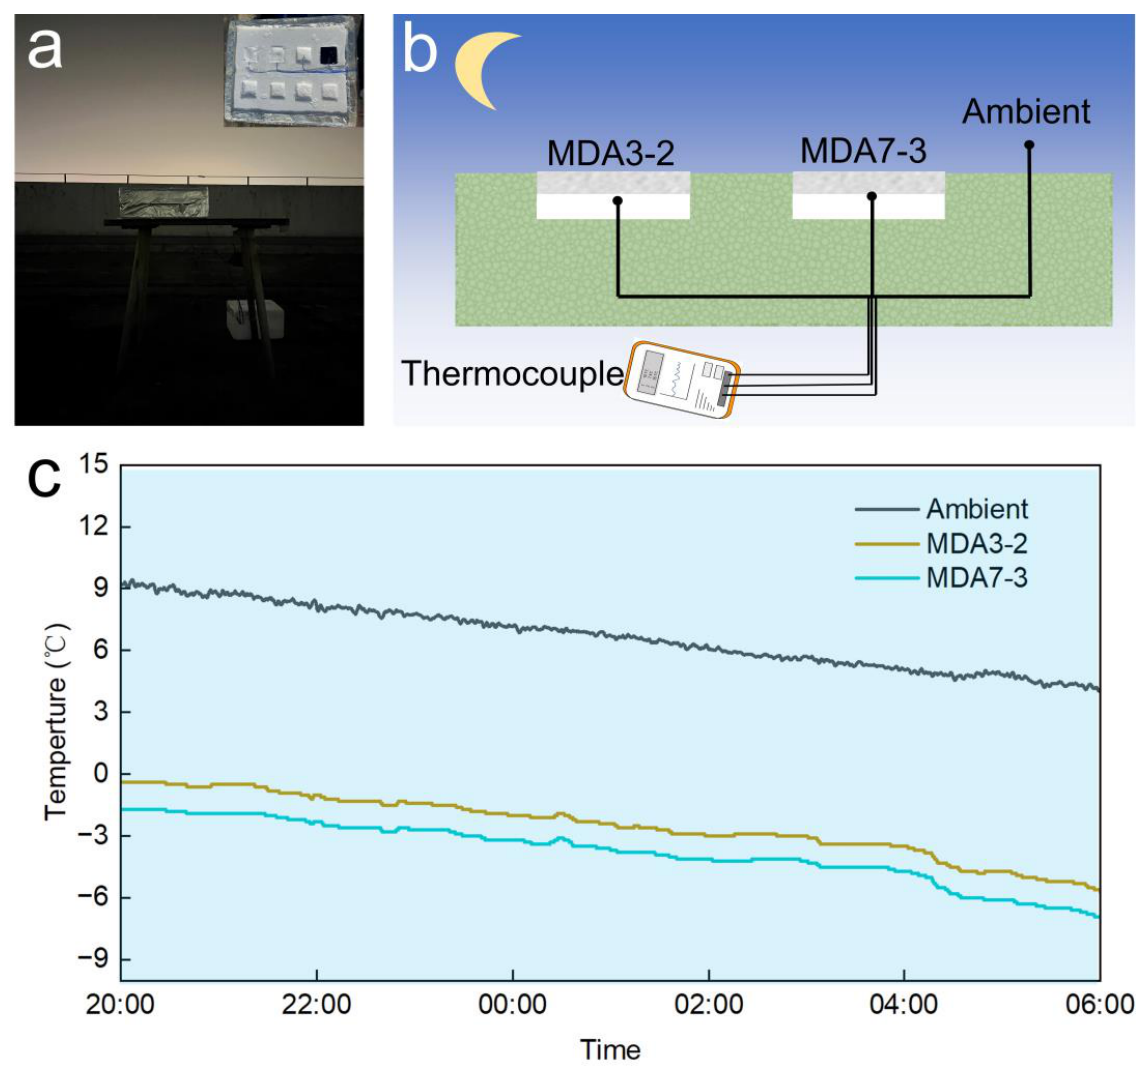
Figure 4. ( a ) Photo image of PRC measurement at night in Suzhou, 12–13 December 2022; ( b ) schematic image of the system used to characterize the PRC; ( c ) temperature tracking of the aerogel and ambient temperature during PRC.